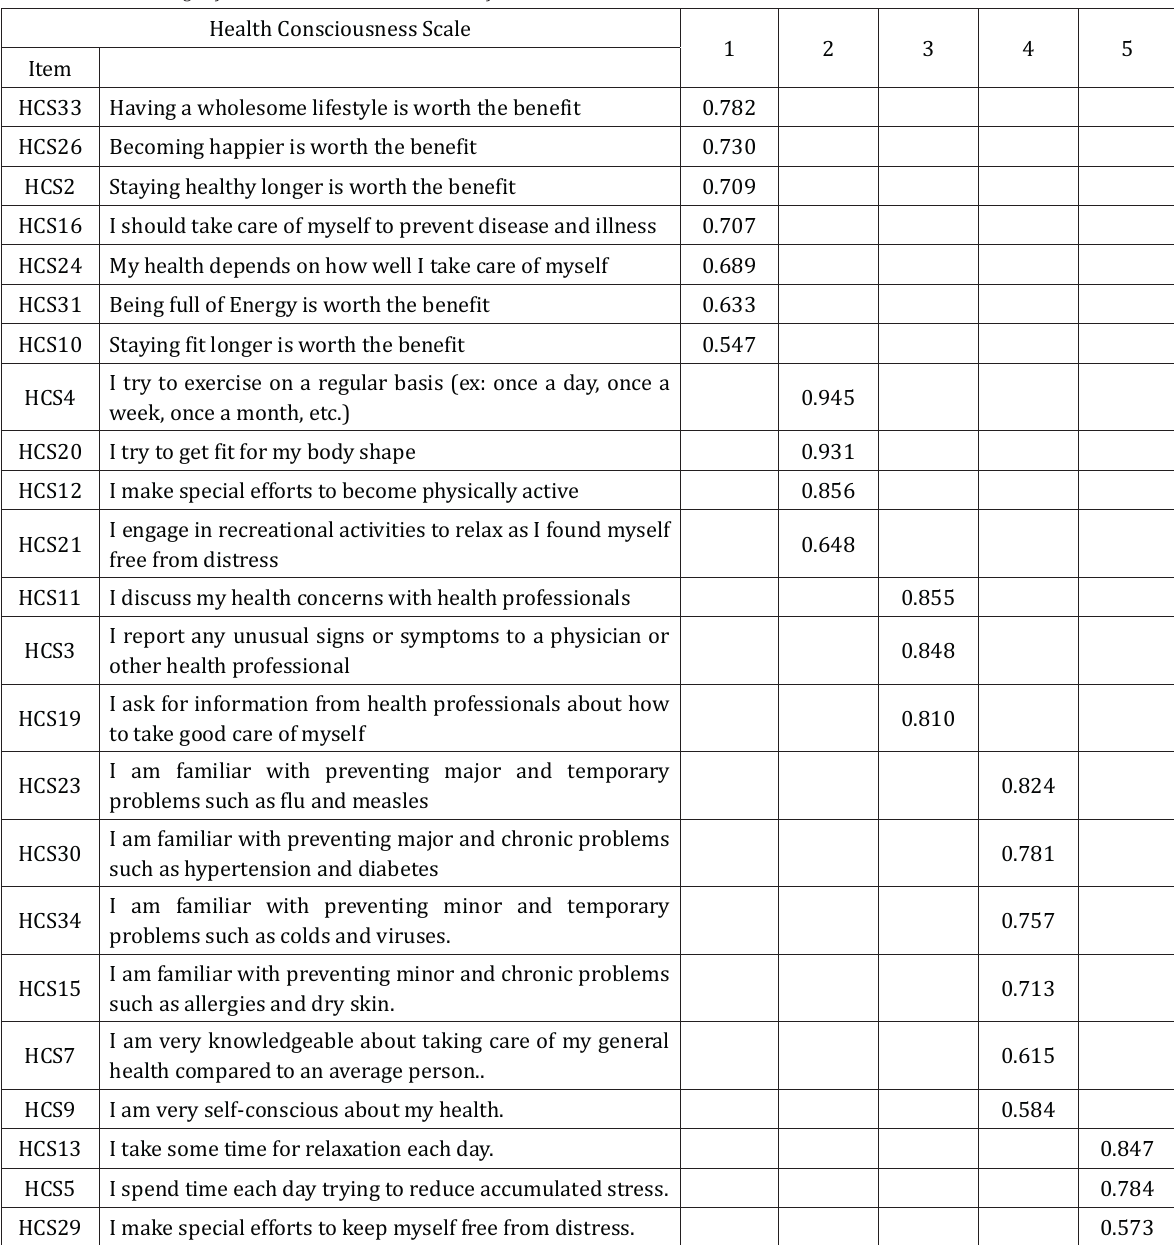
Table 2. Factor loadings of individual entries within the 5-factor tool structure